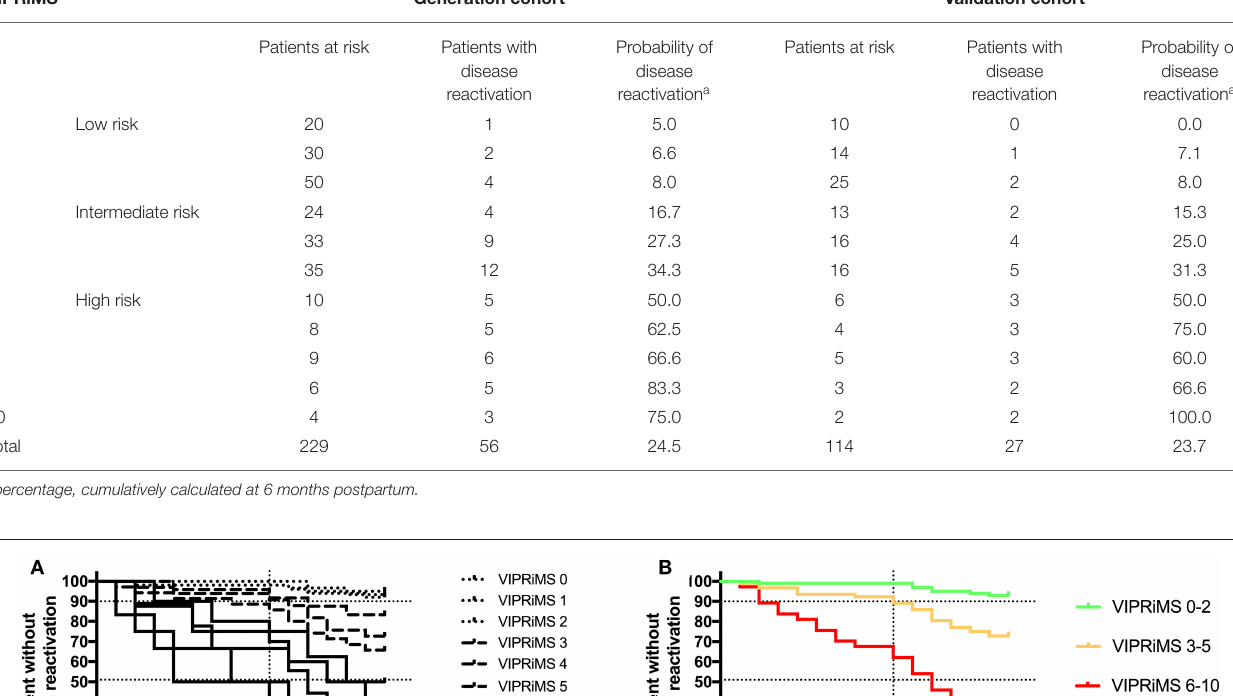
TABLE 3 | Probability of clinical disease activation in pregnancy and within 6 months postpartum stratified according to the Vienna Innsbruck Pregnancy Risk in Multiple Sclerosis (VIPRiMS) score. VIPRiMS